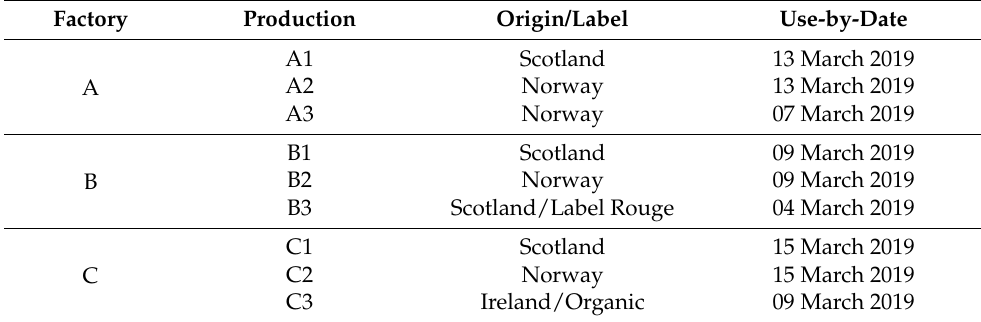
Table 1. Cold-smoked salmon samples description (processing factory, production batch, origin and use-by